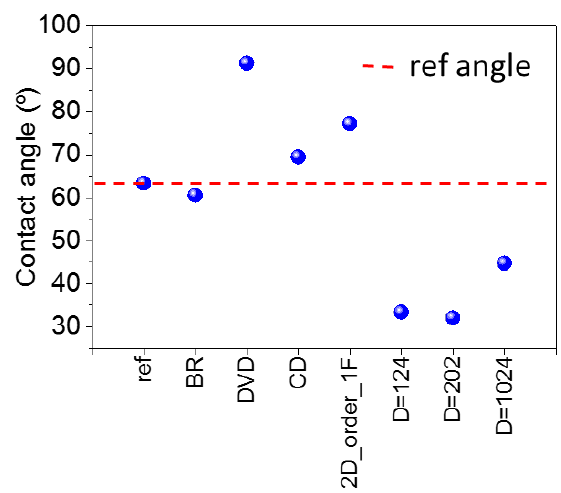
Figure 10. Contact angles of nanostructured glasses and reference sample.